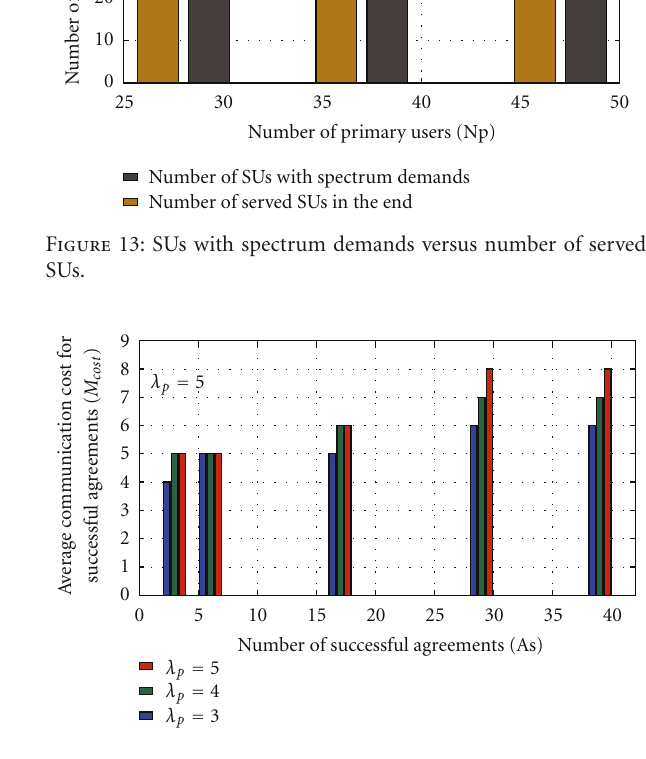
Figure 14: Communication